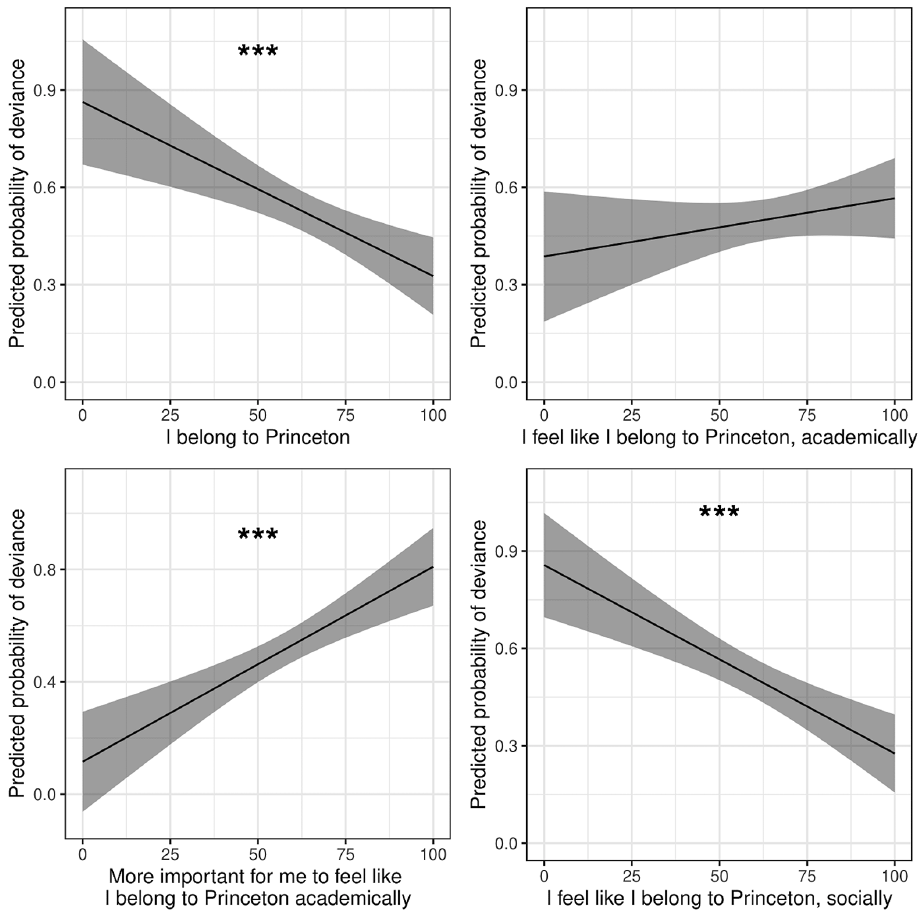
Figure 5. Predicted probability of deviance from the eating club norm based on separate regressions of the binary deviance item on self-reported belongingness items, controlling for demographic variables set at their